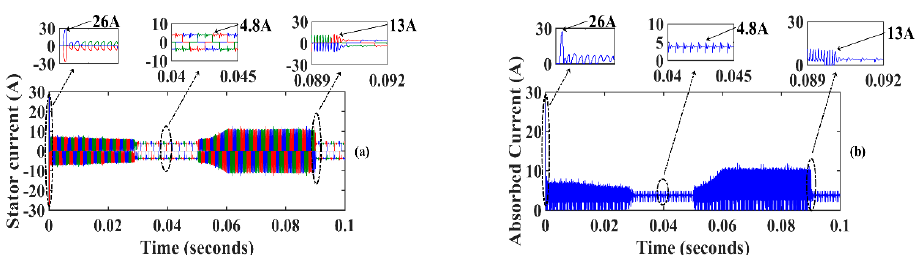
Figure 9. Set point changes.